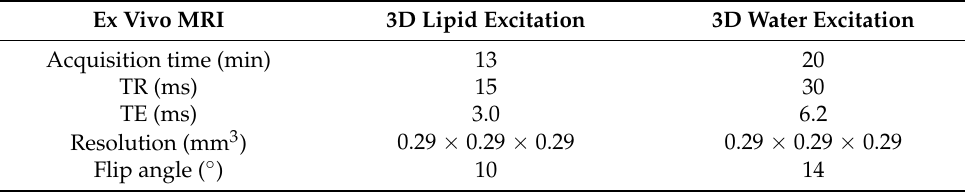
Table 4. Overview of ex vivo MR parameters (7 Tesla, Bruker